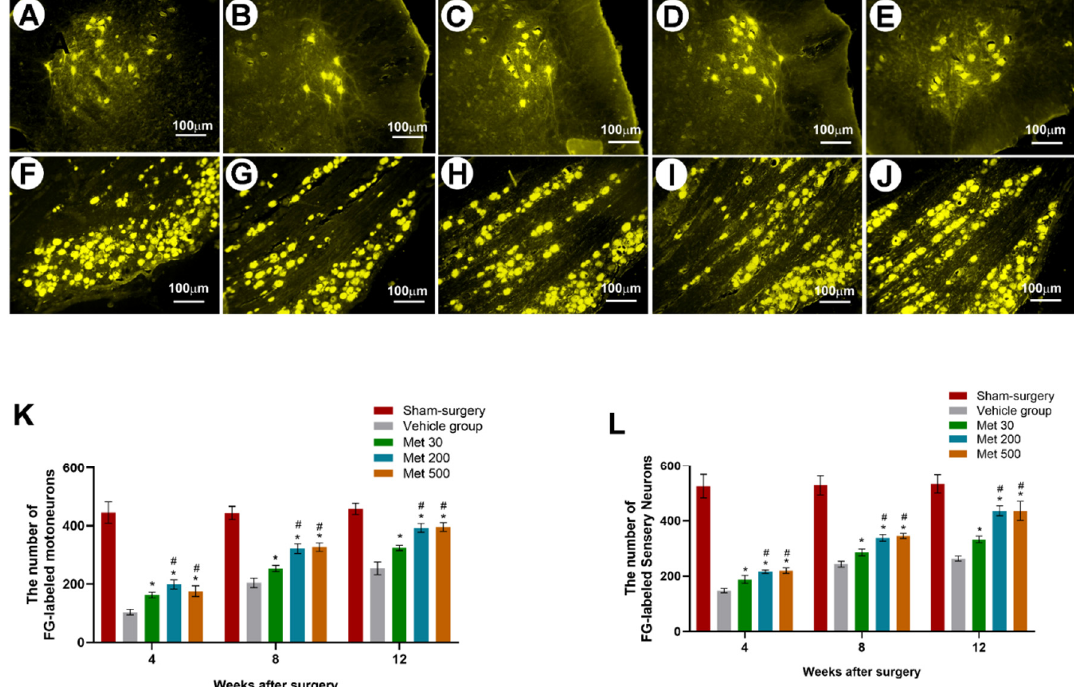
Figure 2. Representative micrographs of FG-labeled motoneurons ( A – E ) and sensory neurons ( F – J ) (L4–L6) in the sham-surgery ( A , F ), vehicle group ( B , G ), metformin at 30 mg/kg ( C , H ), 200 mg/kg ( D , I ), and 500 mg/kg ( E , J ) at 12 weeks after injury. The number of FG-positive motor neurons ( K ) and sensory neurons ( L ). All data are expressed as the mean ± standard error of mean. * p < 0.05 for comparison to the vehicle group. # p < 0.05 for comparison to rats with metformin at low dose (30 mg/kg).